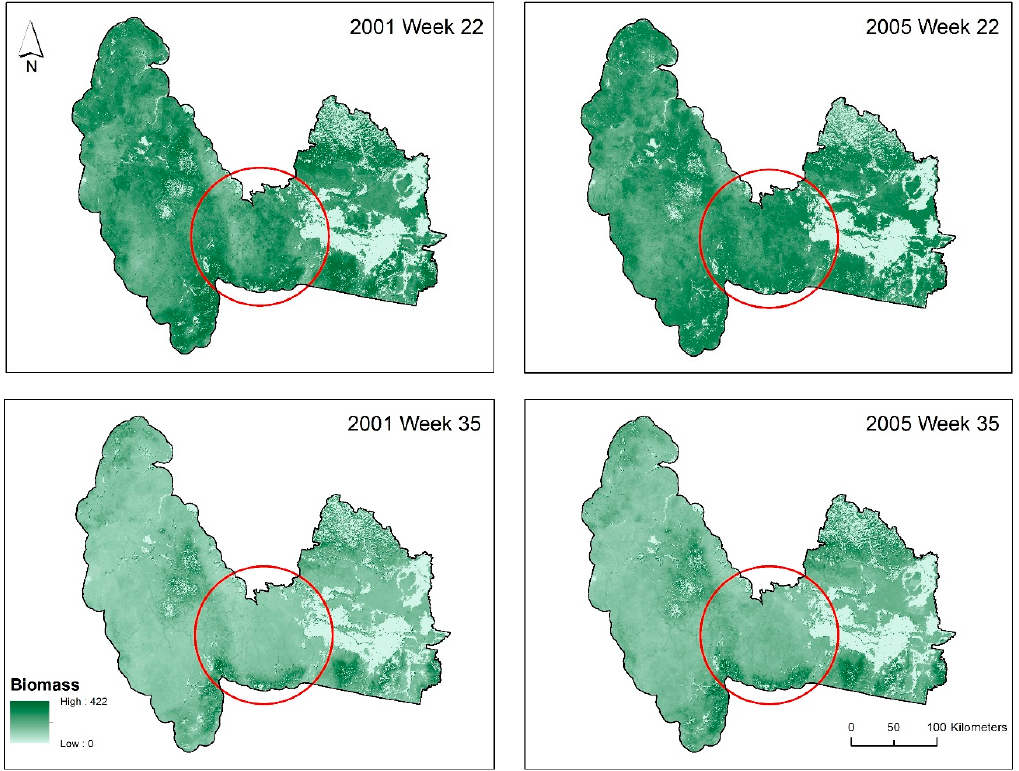
Figure 4. Image comparisons showing live fuels for a low fire year (2001) versus a high fire year (2005) for spring ( top ) and summer ( bottom ). The darker tone of the 2005 spring live fuel image indicates higher biomass for that year. Differences between spring and summer images indicate the loss of green biomass as a function of summer heat and seasonal dryness. The red circle indicates an area where fire occurrence was especially frequent from 2000 to 2011, and includes the Murphy Fire.